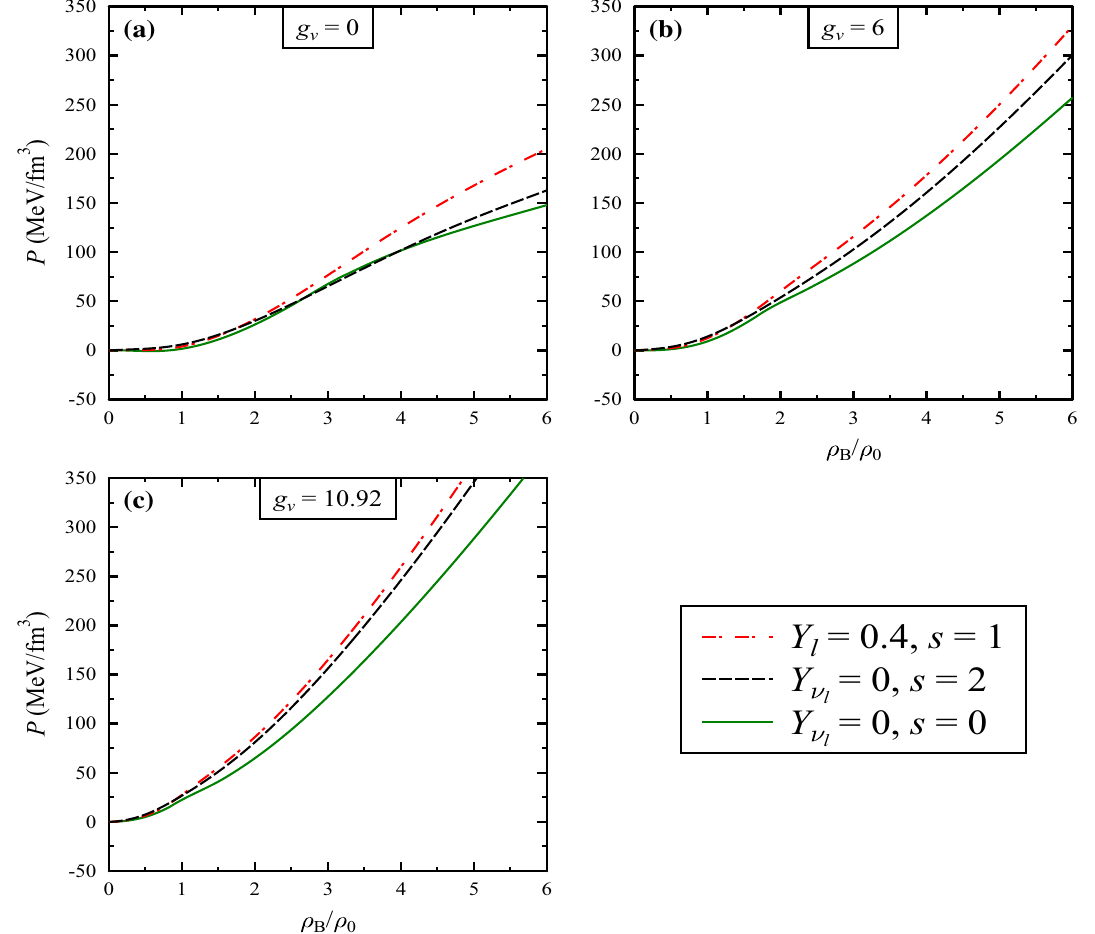
Fig. 6 The behavior of pressure at for different condition of PQS evolution as a function of baryonic density, ρ B (in units of nuclear saturation density ρ 0 ) at g v = 0, 6 and